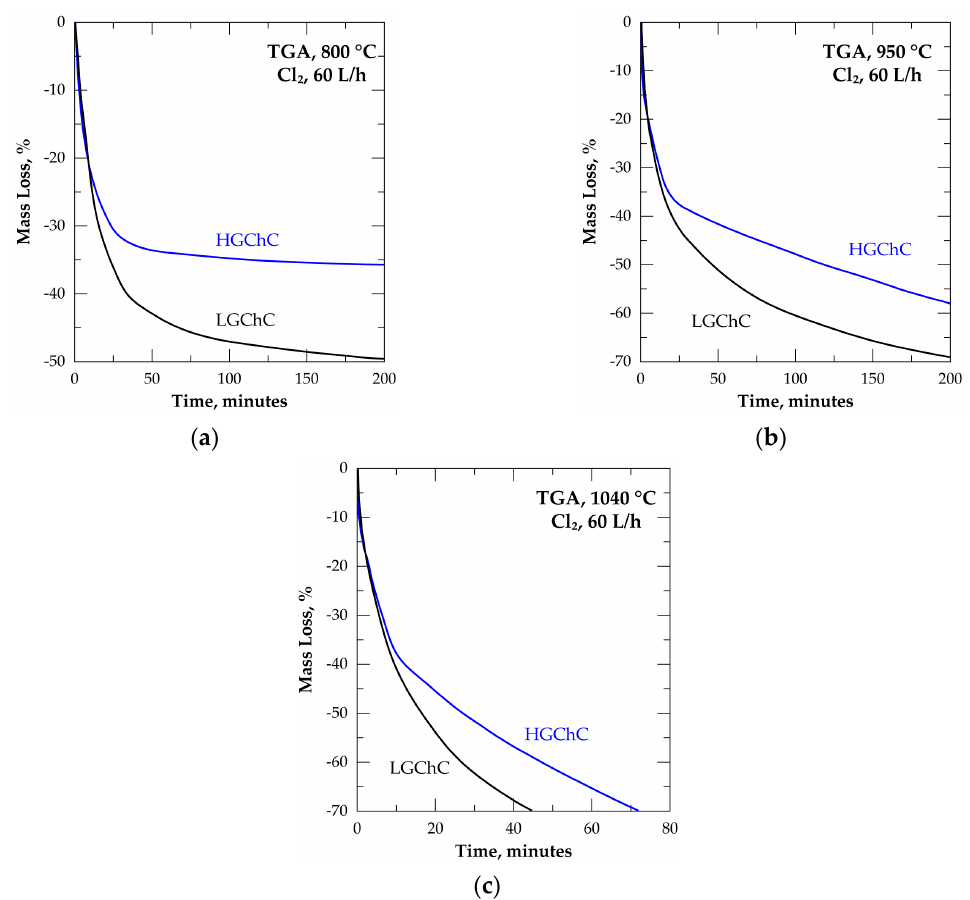
Figure 7. Comparison of the thermal behavior of LGChC and HGChC in Cl 2 atmosphere: ( a ) 800 °C;